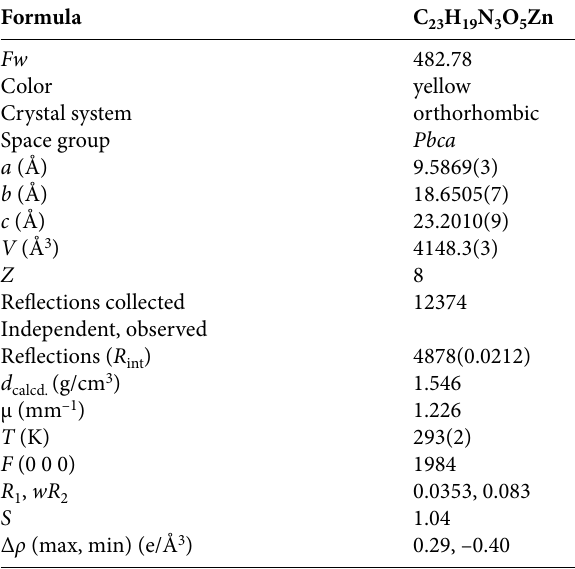
Table 1. Crystal data and structure refinement details for the title com-